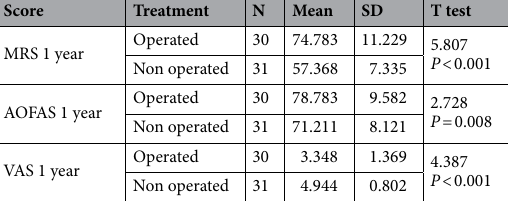
Table 3. Comparison between operated group and the non-operated group at 1 year of follow up.